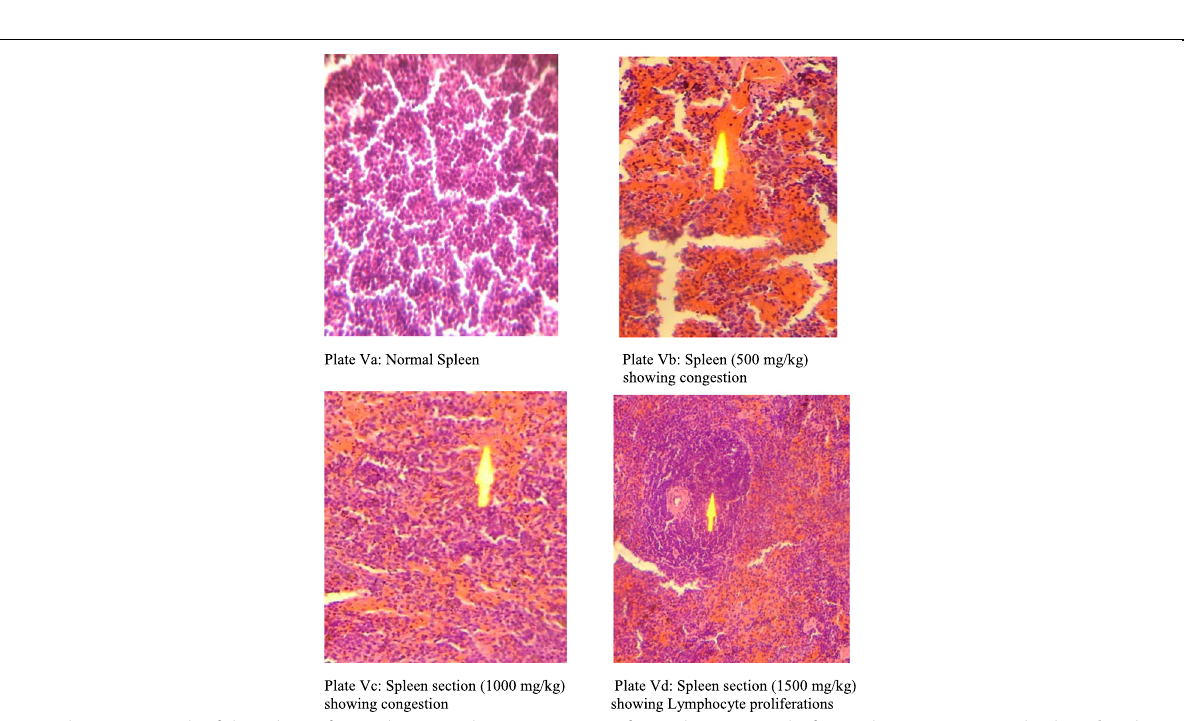
Fig. 5 Photomicrograph of the spleen of rats administered aqueous extract of Spondias purpurea leaf (H and E × 200). a Normal Spleen. b Spleen (500 mg/kg) showing congestion. c Spleen section (1000 mg/kg) showing congestion. d Spleen section (1500 mg/kg) showing Lymphocyte proliferations